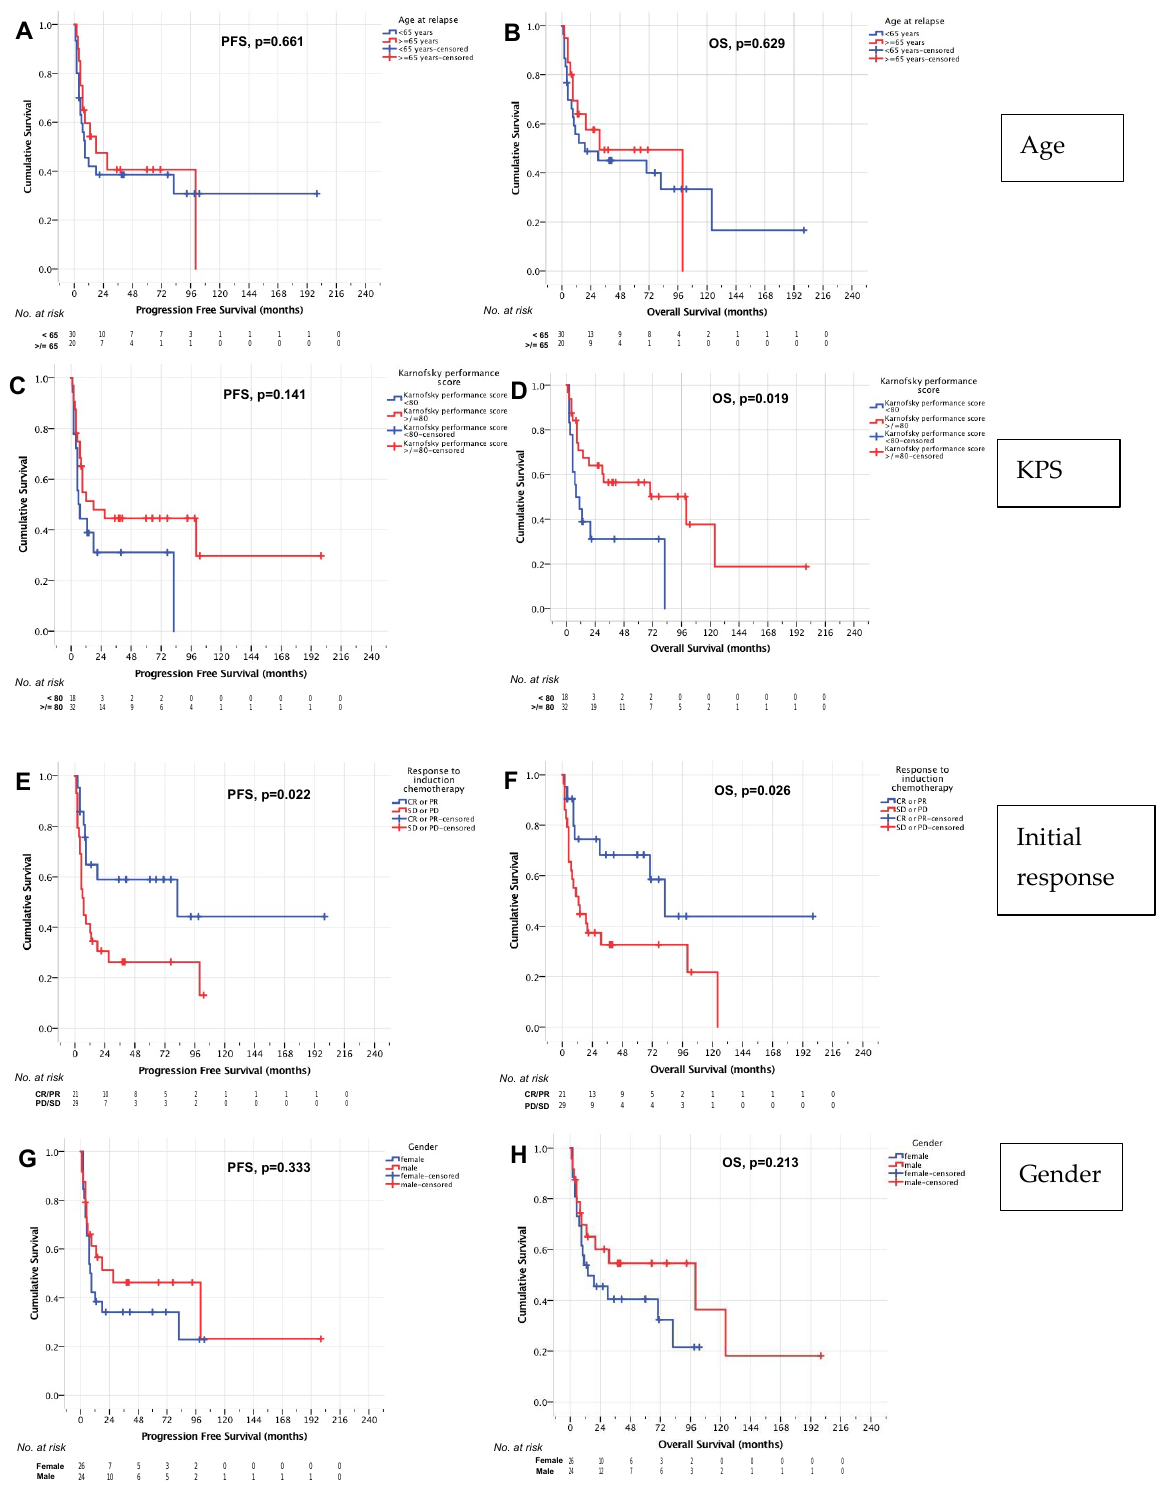
Figure 4. PFS and OS age ( A , B ), Karnofsky performance score ( C , D ), remission status before HCT- ASCT ( E , F ), and gender ( G , H ).